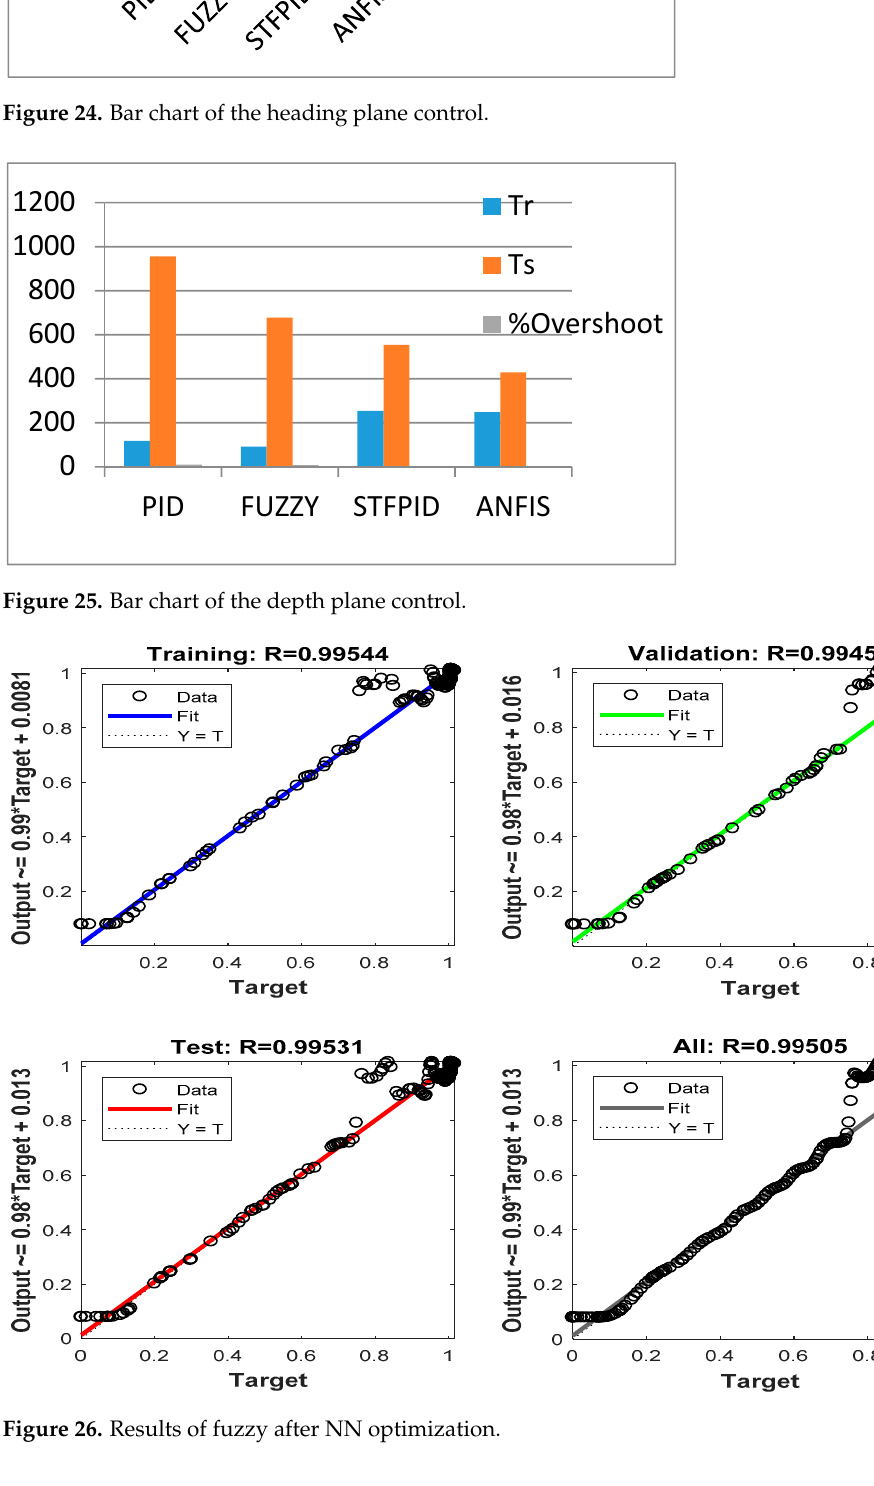
Figure 26. Results of fuzzy after NN optimization.